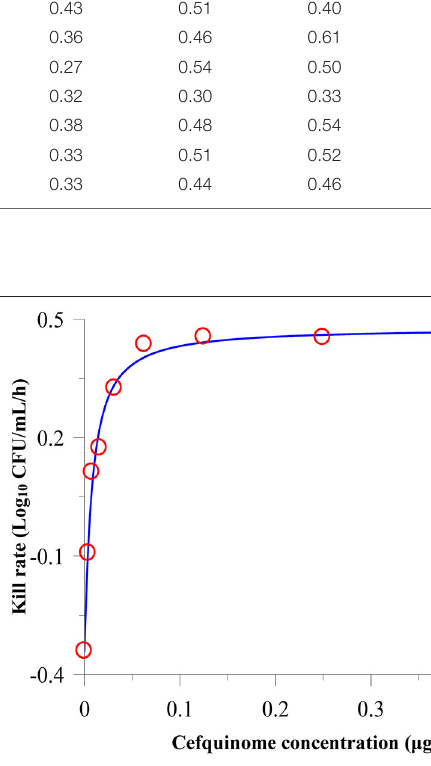
FIGURE 2 | Relationship between the cefquinome concentration and kill rate during 0h to 9 by Sigmoid E max simulation. The R 2 value is the coefficient of